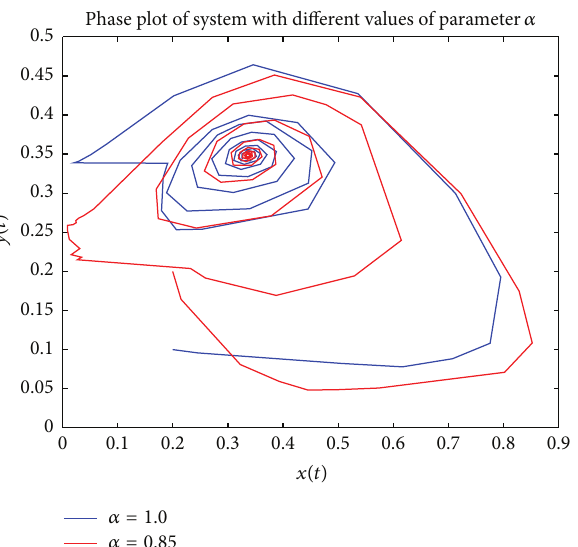
Figure 6: The simulations show that period of Hopf bifurcation changes with the controlled parameter 𝛼 .